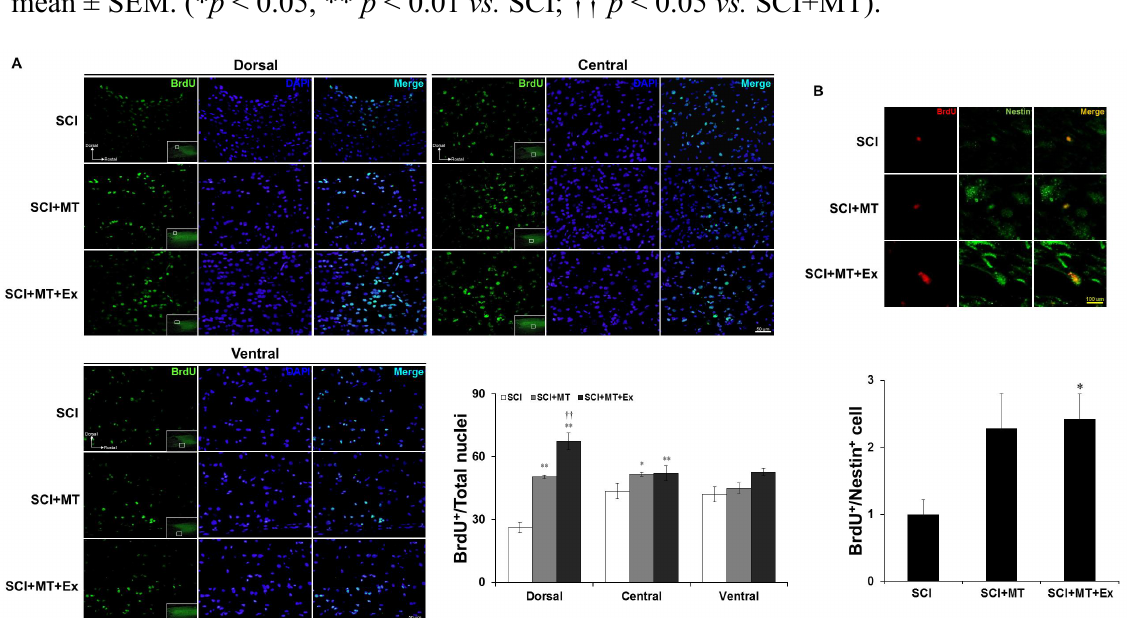
Figure 3. Effects of melatonin and melatonin combined with therapeutic exercise on proliferation of neural stem/progenitor cells after SCI. ( A ) BrdU-positive proliferative cells in the dorsal, central, and ventral site of rostral perilesion at day 21 after SCI.Parasagittal section of rat spinal cord labeled with BrdU (green) and DAPI (blue) in SCI, SCI+MT, and SCI+MT+Ex groups at day 21 after spinal cord injury. BrdU-labeled cells are an index of newly born dividing cells because BrdU is incorporated into replicating DNA; DAPI-labeled nuclei are an index of total cells because they bind to double-stranded DNA. In the merged images, colocalization of BrdU and DAPI is labeled in sky-blue. ( B ) Melatonin combined with exercise doubled the proportion of BrdU-positive cells that were also nestin-positive endogenous neural stem/progenitors at day 21 after injury. BrdU-positive and nestin-positive cell morphology in the 1 mm rostral perilesion site in longitudinal sections at day 21 after spinal cord injury.BrdU staining (red), nestin staining (green), and their co-localization (yellow). Comparisons were conducted by one-way ANOVA using the SPSS software and post hoc Tukey’s tests. Data are expressed as mean ± SEM. (* p < 0.05, ** p < 0.01 vs. SCI; †† p < 0.05 vs.